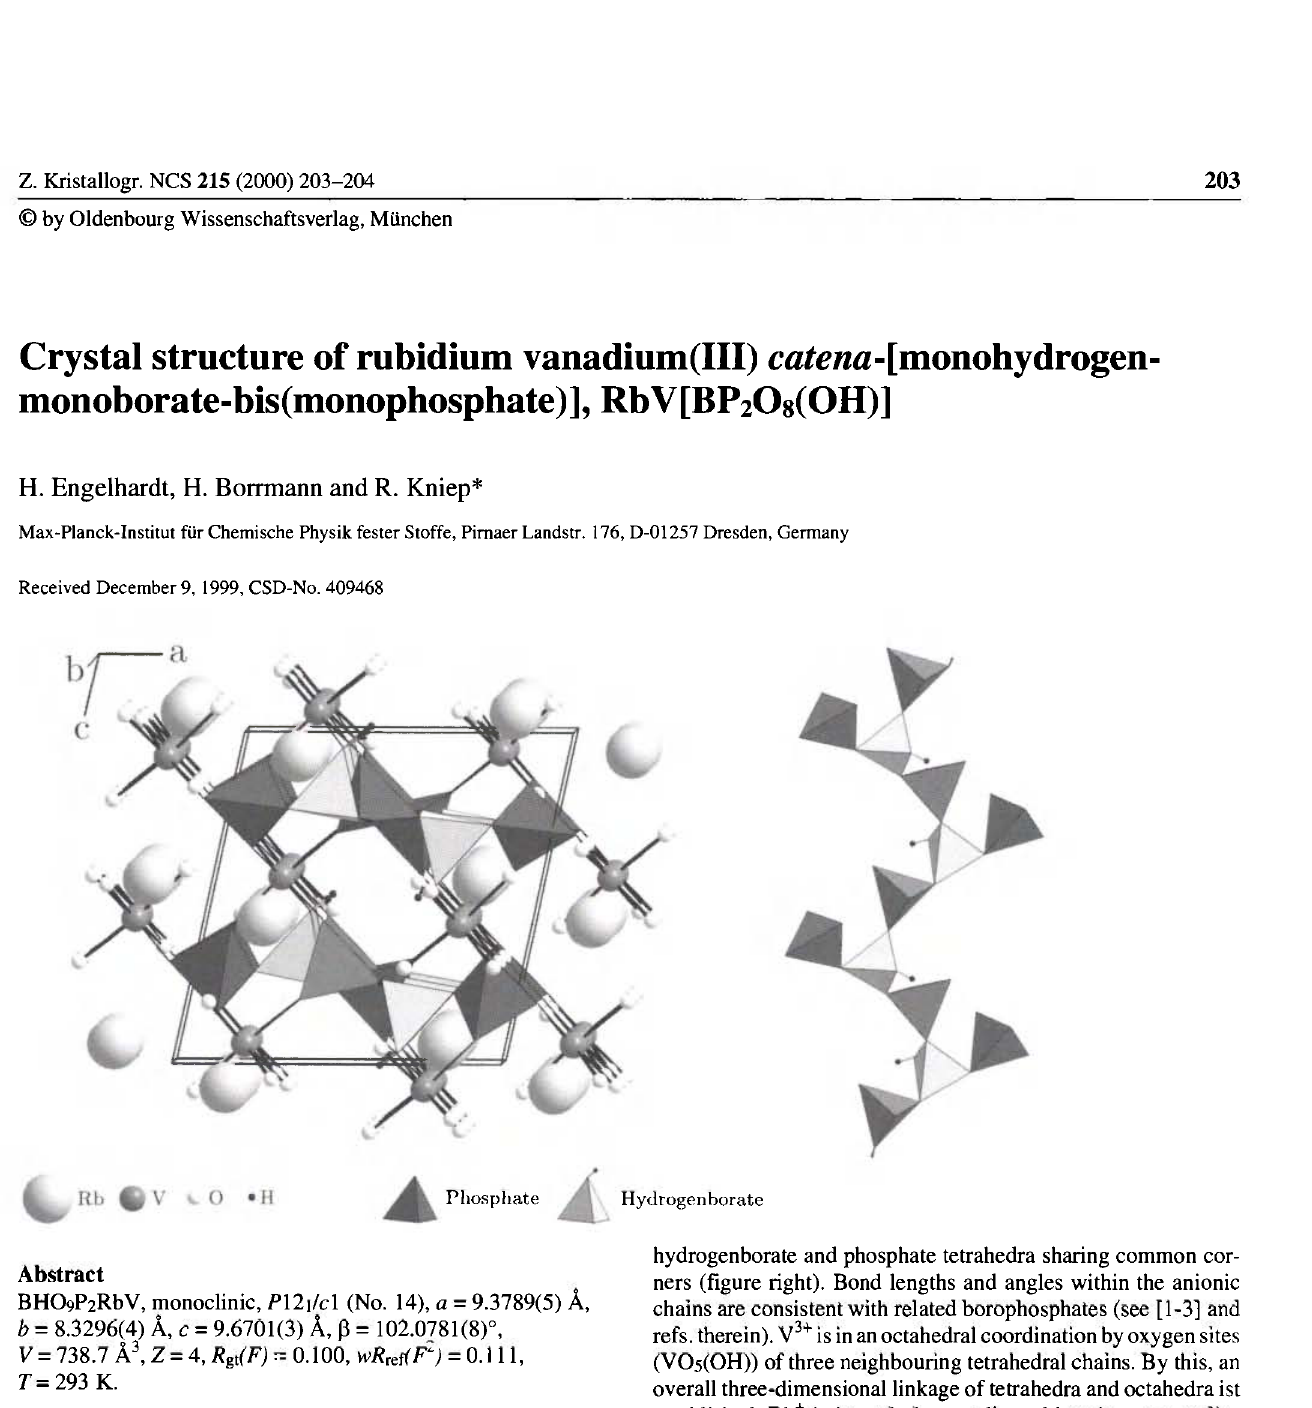
Table 1. Data collection and handling.